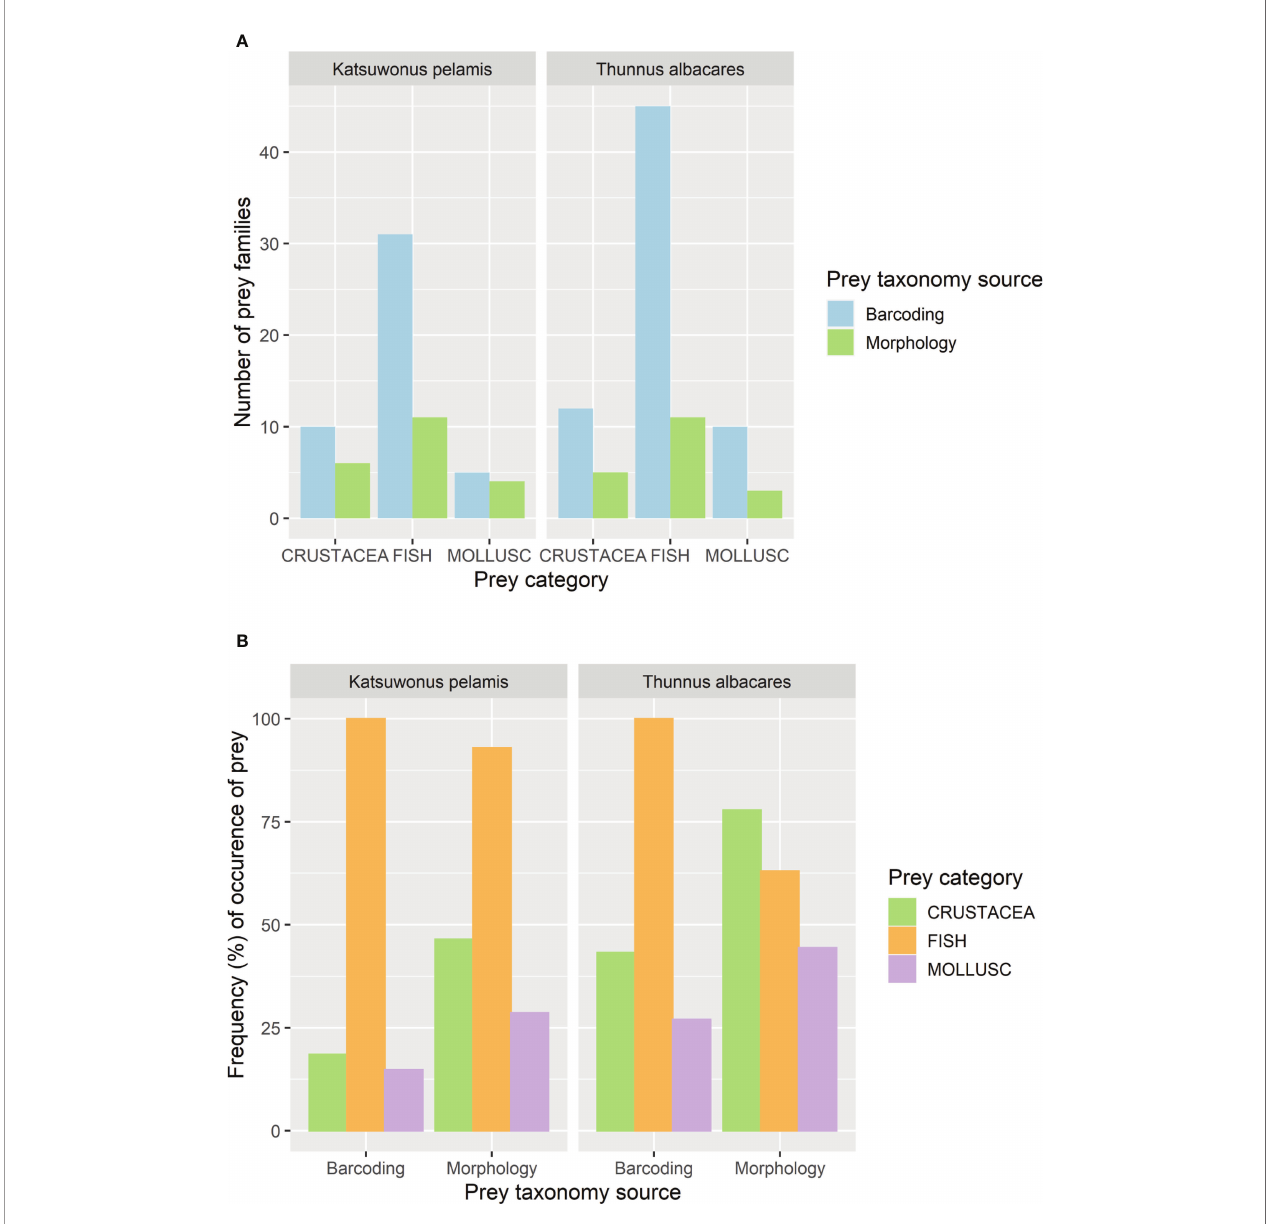
FIGURE 4 | Prey diversity in number of prey families (A) and frequency of occurrence of the prey categorised by main groups (B) , identi fi ed in stomach contents of Katsuwonus pelamis and Thunnus albacares using high throughput sequencing (Barcoding) and morphological assessments